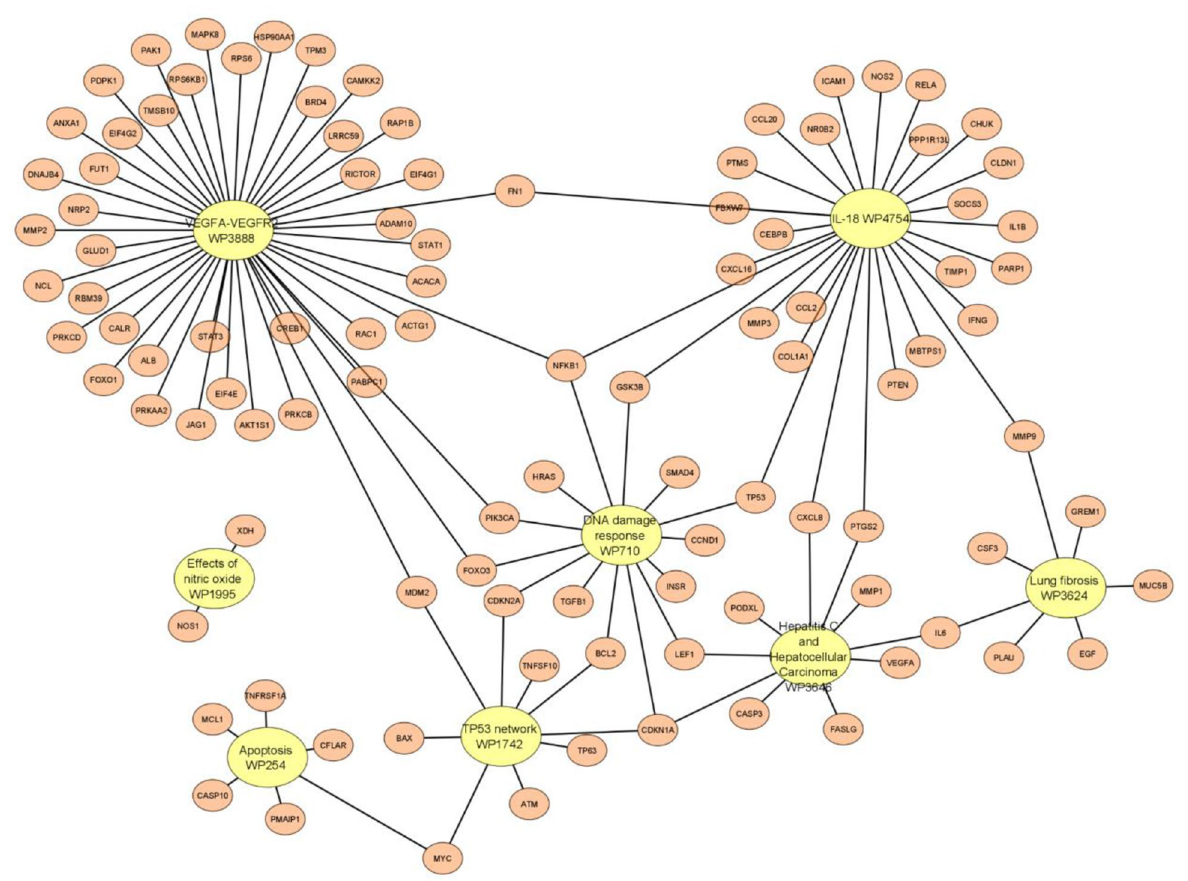
Figure 9. Network visualization of the gene interaction for the cell signaling pathway with overlapping genes for the ten GEO datasets using the cytoscape